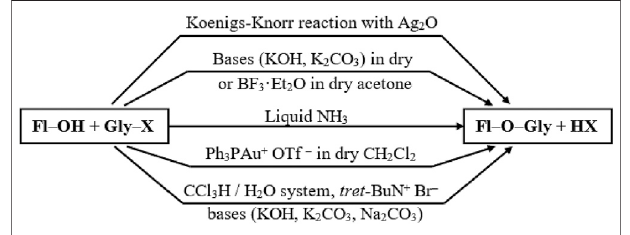
FIGURE 2 | Main pathways of fl avonoid